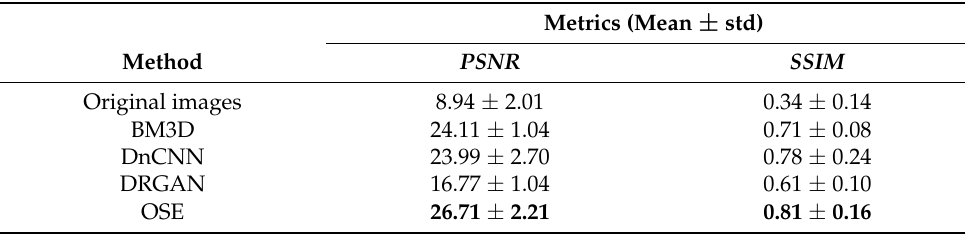
Table 2. Quantitative performance comparison with state-of-the-art methods for OCT image enhancement.